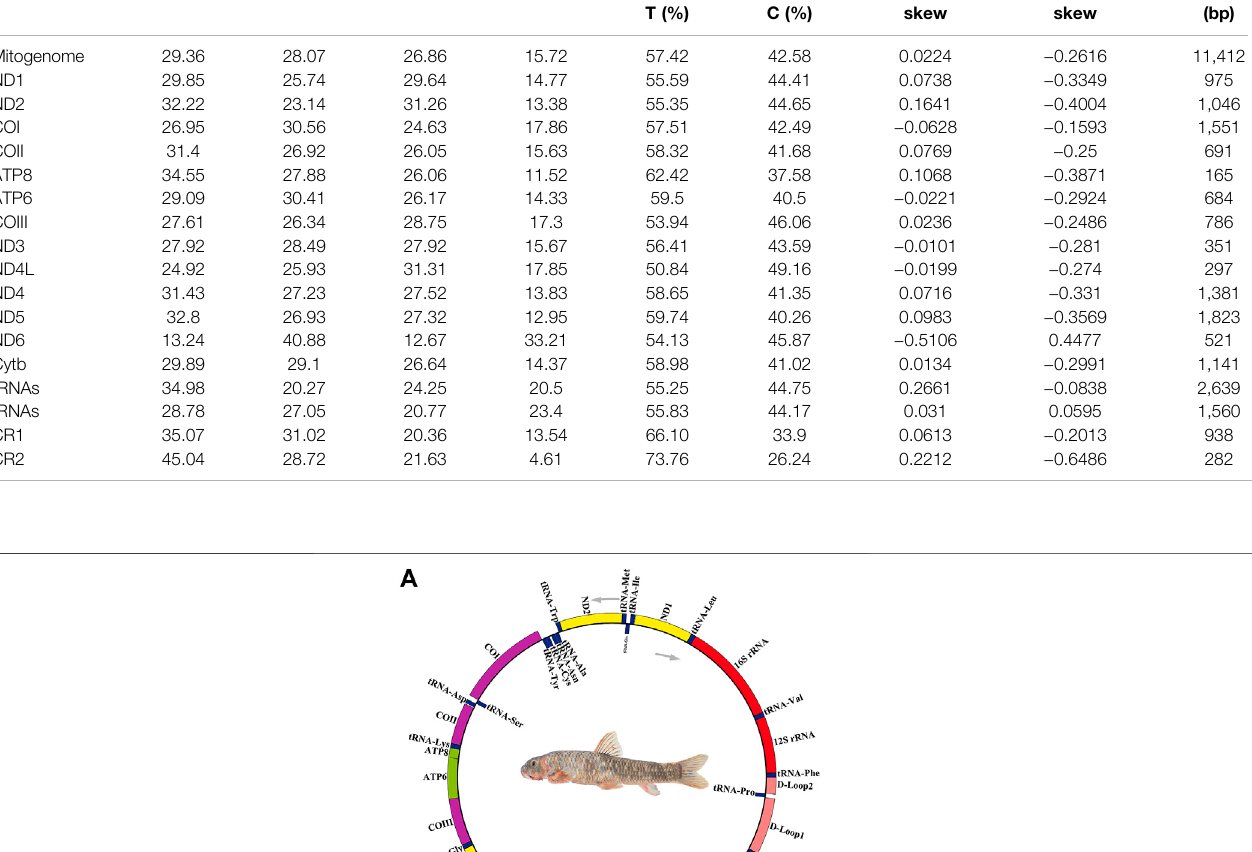
TABLE 2 | Composition and skewness of Garra dengba mitogenome. Gene